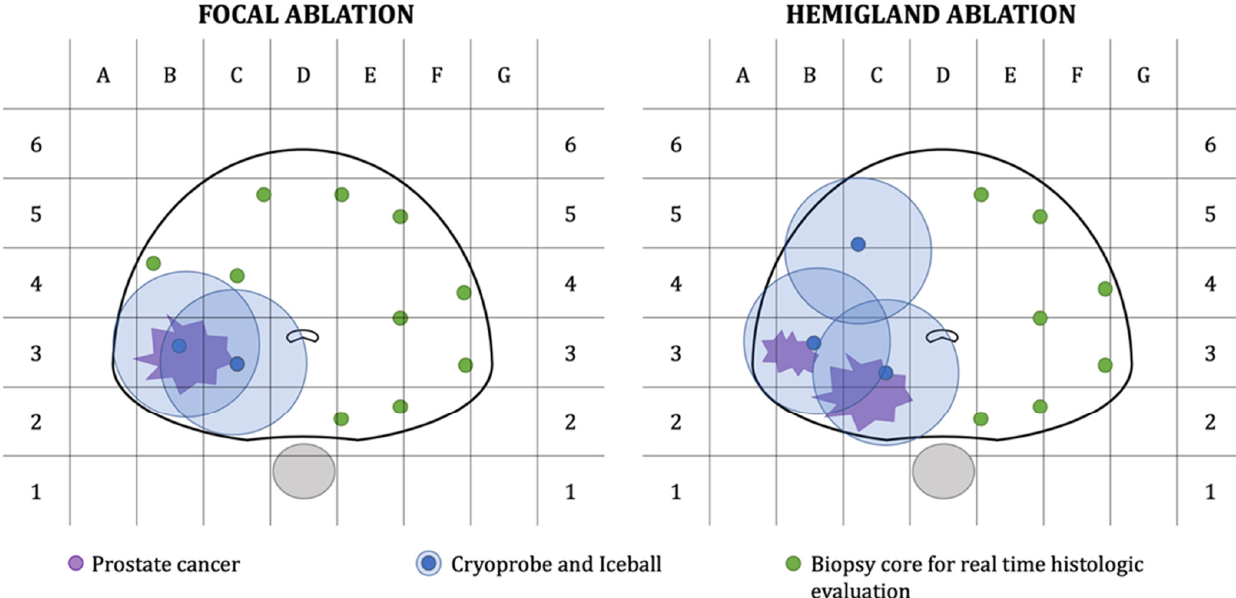
Figure 1. Graph representation of treatment plan and biopsy core template for patients undergoing focal or hemigland cryoablation.